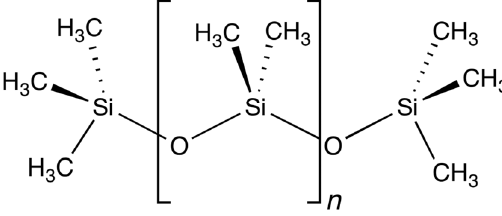
Figure 2. The constitutional formula of PDMS.